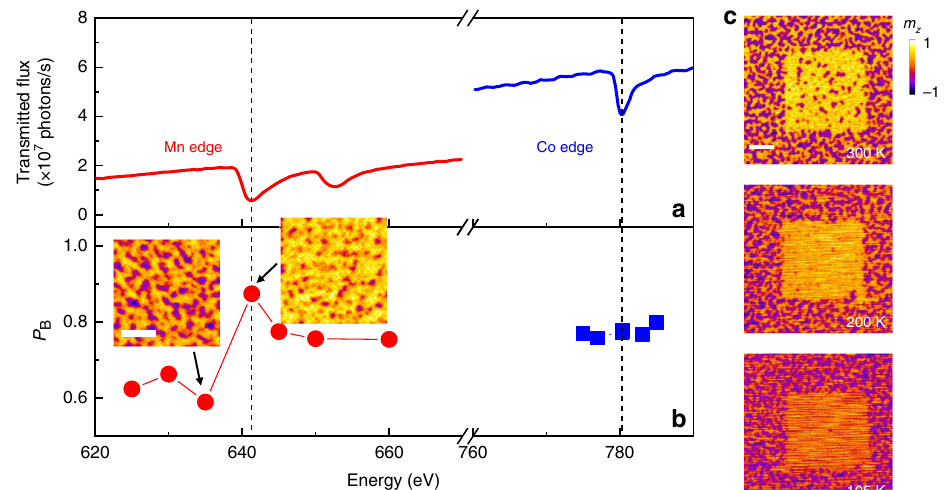
Fig. 2 Photon energy and temperature dependence of the exchange bias reorientation effect. a Detected photon fl ux after transmission through the sample as a function of photon energy. The fl ux is calculated based on the detected photons within 2s by the detector behind the sample. b Percentage of the bright area P B = S ( M ↑ )/ S ( M ↑ + M ↓ ) as a function of photon energy. S ( M ↑ ) and S ( M ↓ ) represent the area for magnetization point up (bright) and down (dark), respectively. The red dots (blue square) show the effect of X-ray illumination on the energy near the Mn (Co) edge. The measurements were done for a sample with 0.4-nm-thick Co layer. The scale bar is 1 μ m. c Zero- fi eld magnetic domain pattern (6 μ m×6 μ m) after scanning the central area (3×3 μ m 2 ) using X-ray under a magnetic fi eld of 2000 Oe at 300, 200, and 105K. The dwell time used for scanning each pixel is 3ms. The scale bar is 1 μ